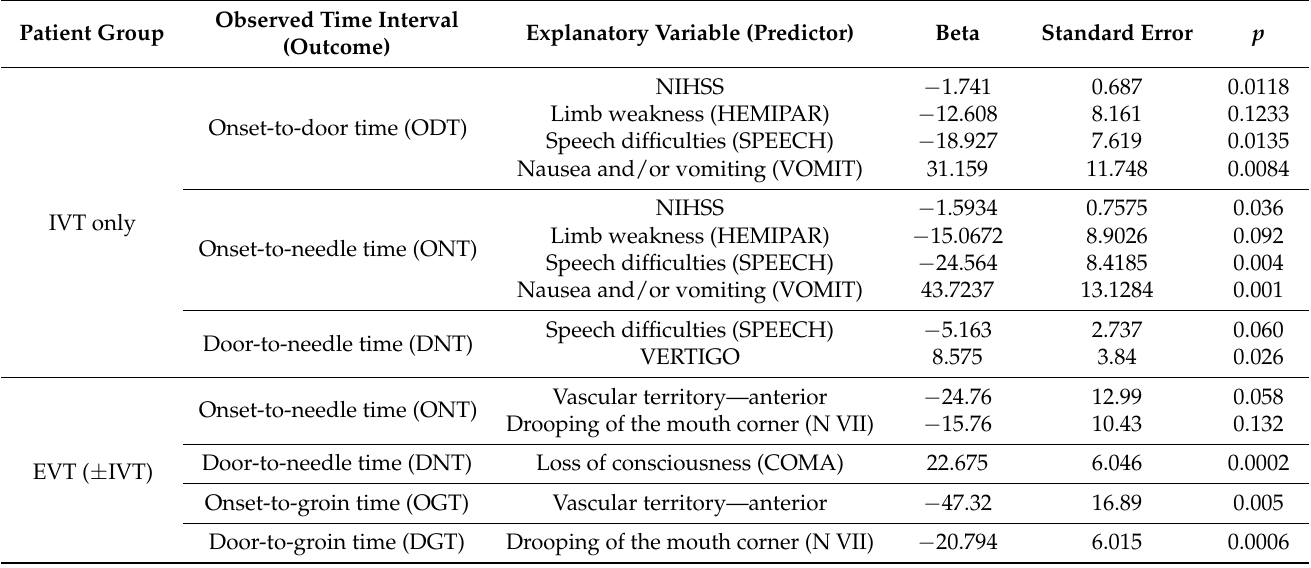
Table 4. Best multivariable models of observed time